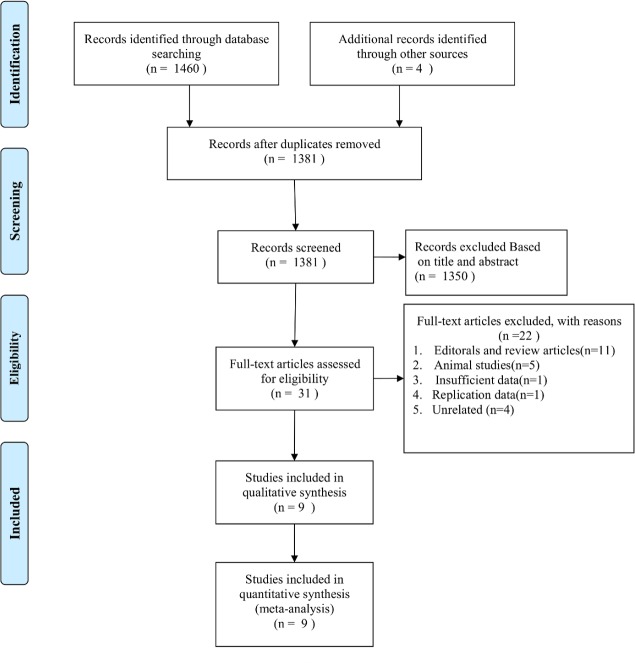
Flow diagram of study selection.